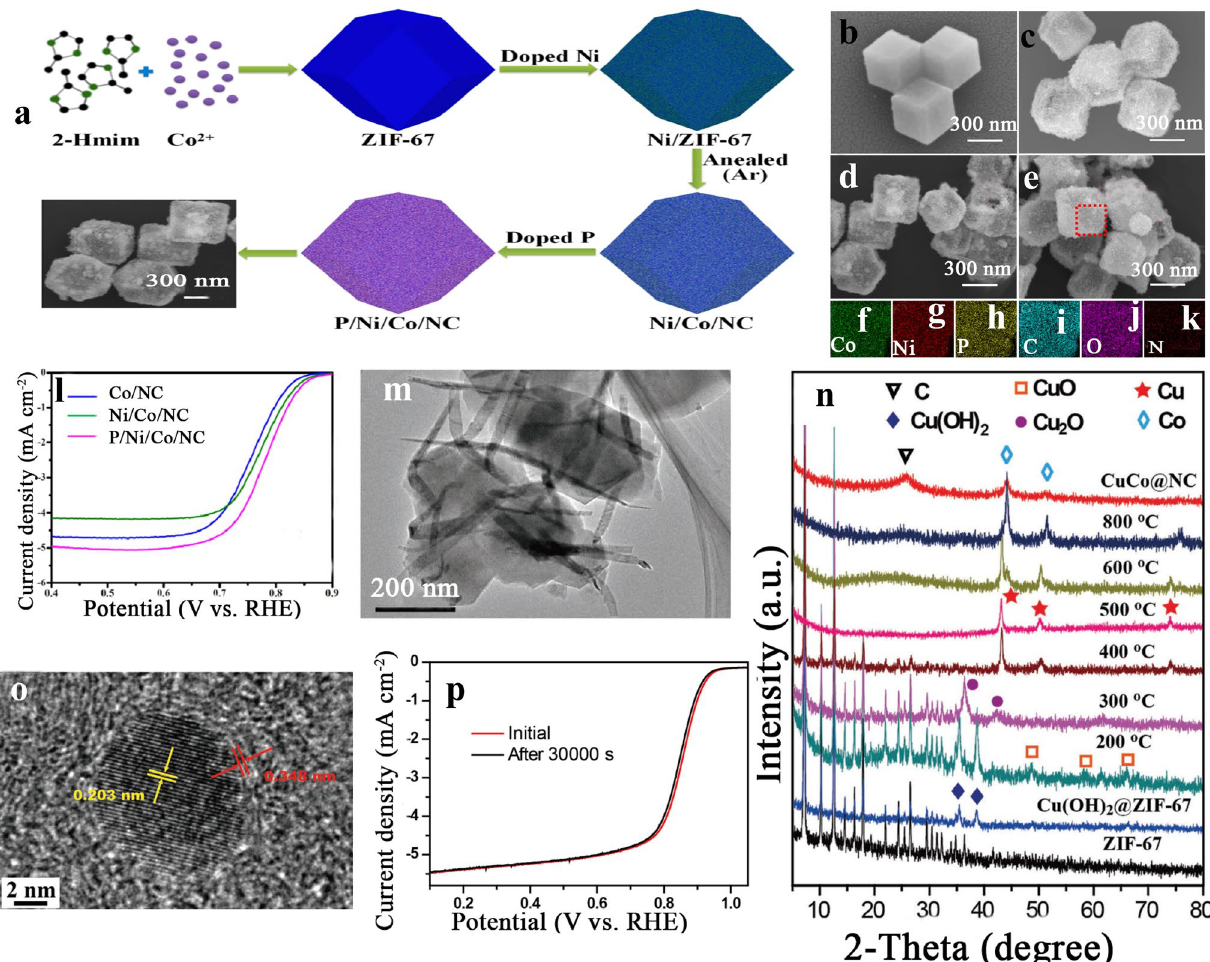
Fig. 7 a Schematic illustration of the synthesis of Ni/Co/NC electrocatalyst. SEM images of b ZIF-67, c Ni/ZIF-8, d Ni/Co/NC, e P/Ni/Co/ NC, f–k EDS maps of P/Ni/Co/NC and l linear sweep voltammetry of Co/NC. Ni/Co/NC, P/Ni/Co/NC in O 2 -saturated 0.1 mol L −1 KOH at a scan rate of 10 mV s −1 with an RDE rotation rate of 1600 rpm [144], Copyright© 2018, Elsevier. TEM images of ZIF-67 polyhedrons grown on Cu(OH)2 nanowires m , XRD patterns of ZIF-67, Cu(OH)2@ ZIF-67, Cu(OH)2@ZIF-67 calcined at different temperatures of 200, 300, 400, 500, 600, and 800 °C, and CuCo@NC n , HRTEM image of CuCo@NC composite o and LSV curves of CuCo@NC before and after stability test at an RDE rotation rate of 1600 rpm in O2-saturated 0.1 M KOH p [145], Copyright © 2017, John Wiley and